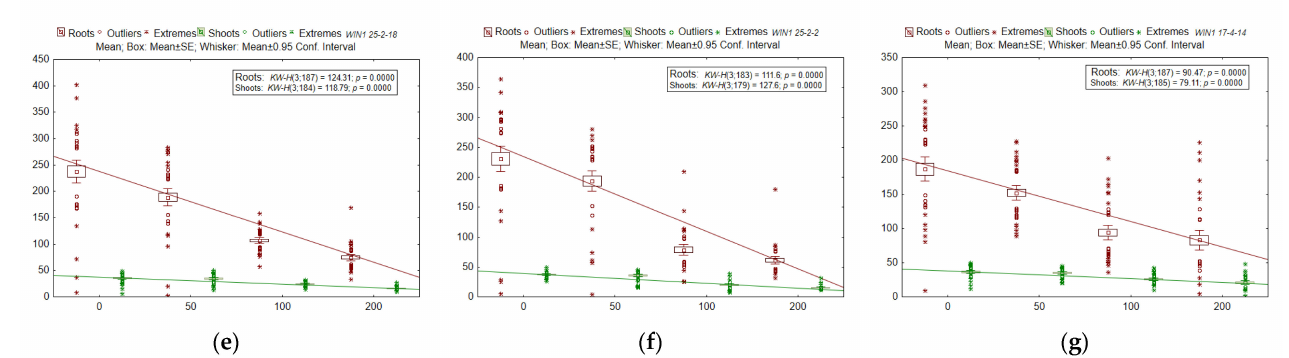
Figure 5. The average shoot length (mm) and the total root length (mm) in seedlings of barley KO lines after irradiation. ( a ) WT, ( b ) nud 07-1 , ( c ) nud 05-4 , ( d ) nud 01-4 , ( e ) win1 25-2-18 , ( f ) win1 25-2-2 , and ( g ) win1 17-4-14 . The x -axis denotes radiation doses (Gy). The number of samples for each dose or line was N = 41–48 (shoots) and N = 43–48 (roots). The mean, standard error (SE) and 95% confidential interval are indicated in the Figure 5. The nonparametric Kruskal-Wallis (KW) method was used, where H is the criterion value, p -value is the significance level. The degree of freedom ( df ) values of the numerator and denominator of H -criterion are given in